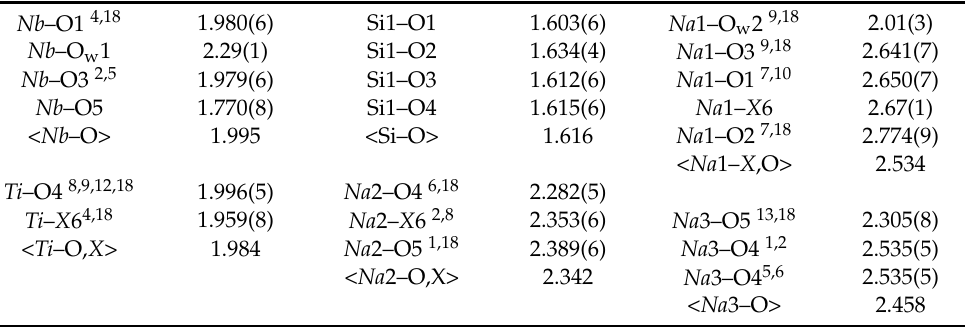
Table 5. Selected bond lengths (Å) in the crystal structure of shkatulkalite.